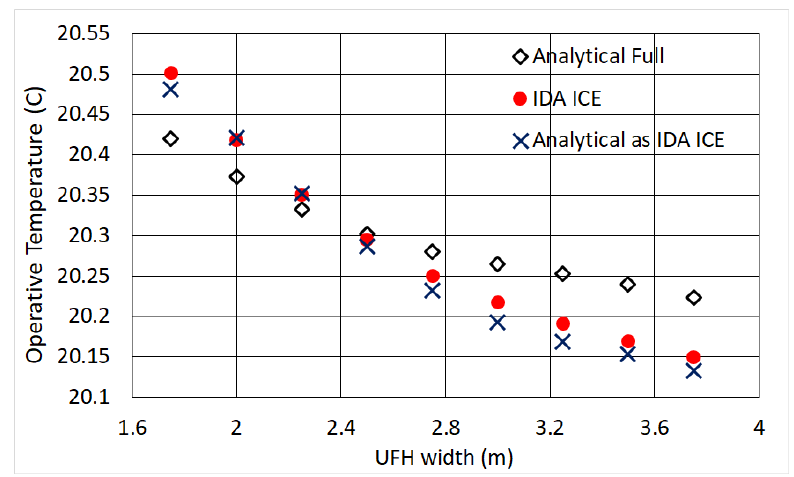
Figure 15. Operative temperature for a square UFH.